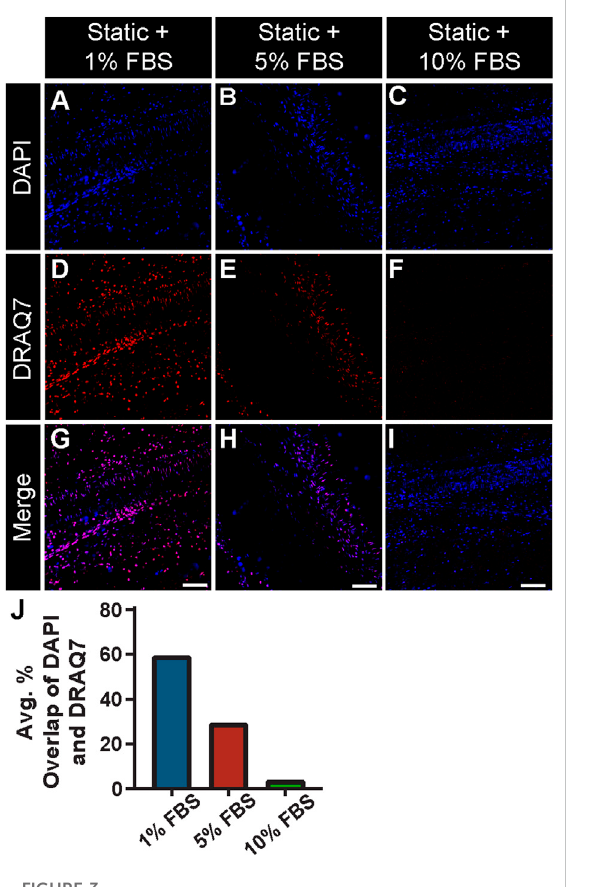
FBS Concentration Assessment with a Cell Viability Assay under Static Conditions. Representative images of DAPI-labeled cell nuclei [blue in (A – C) and (G – I) ] relative to compromised cell nuclei labeledwith DRAQ7[redin (D – I)] ina48 hstatic tissue culture of intestinal sections with 1% (A,D,G) 5% (B,E,H) and 10% FBS (C,F,I) in media. Note, 10% FBS showed a signi fi cant reduction of cell death compared to 5% and 1%, with the percent overlap of DAPI and DRAQ7 found to be 54.58%, 15.60%, and 1.82% for 1%, 5%, and 10% FBS concentrations, respectively. Therefore, 10% FBS was used in the experimental setup with controlled fl ow. Scale Barsin (G,H,I) are100 μ m. (J) AveragepercentoverlapofDAPIand DRAQ7 signals across the intestinal tissue area under